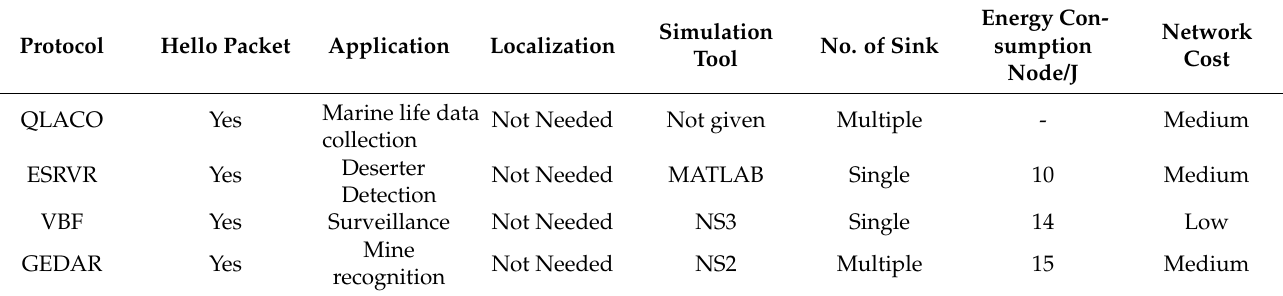
Table 12. Comparison of Location-Based Routing Protocol.